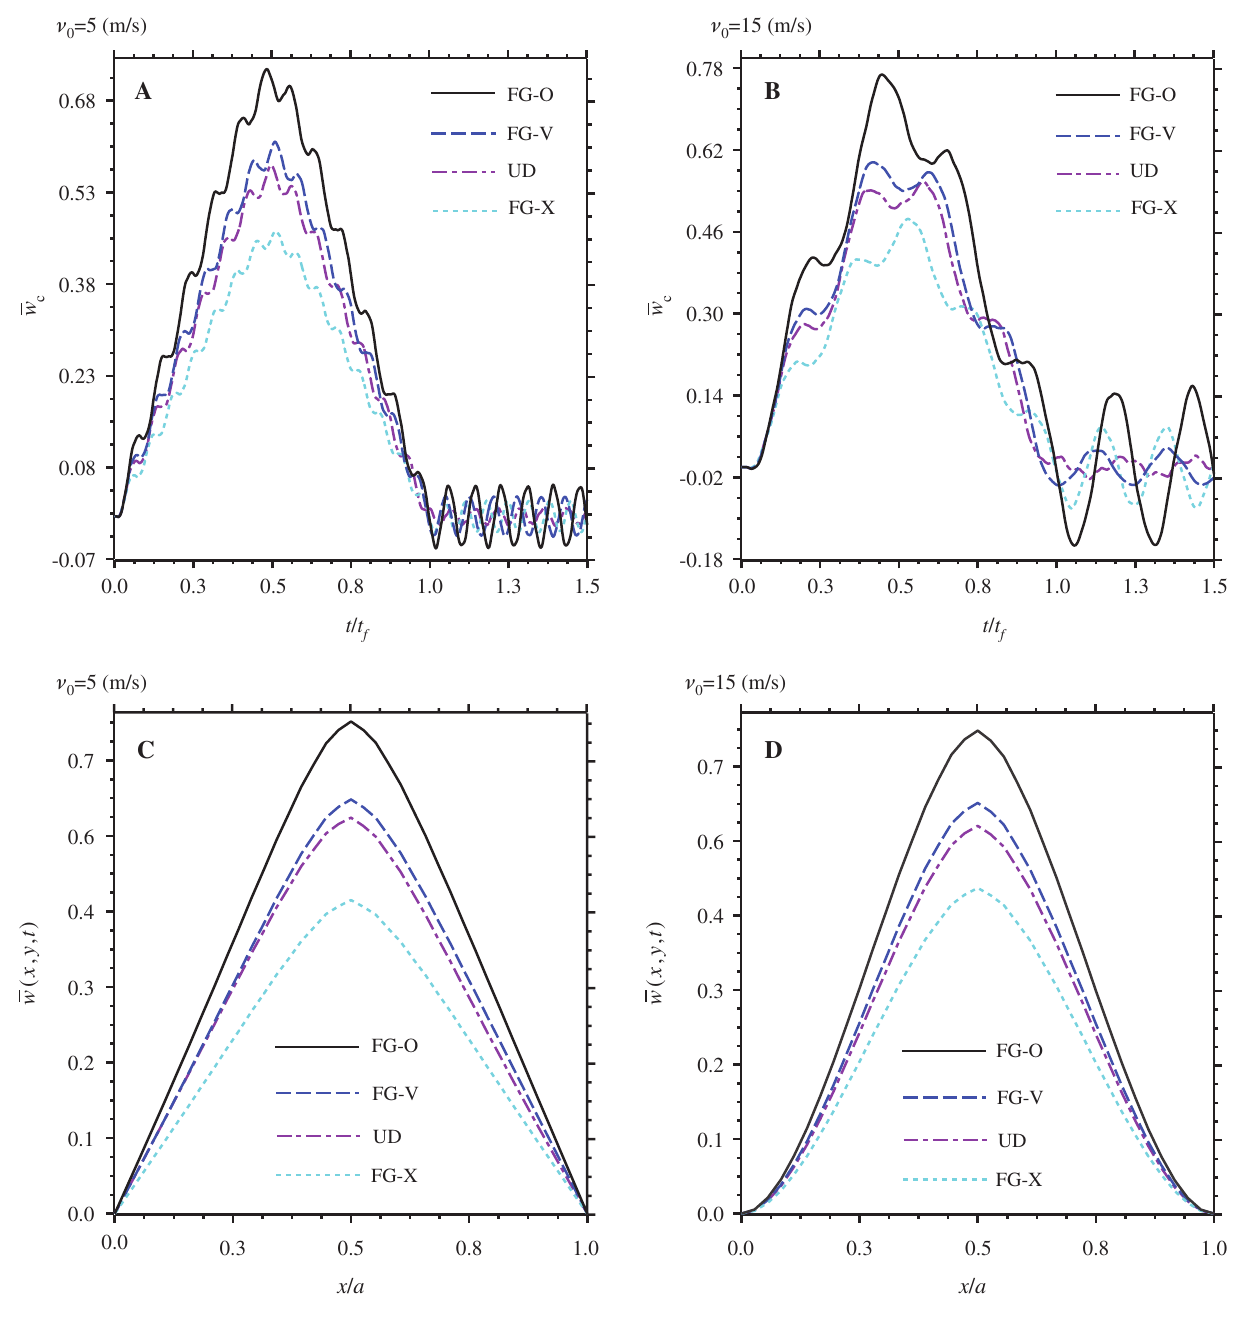
Figure 5 The influence of three different CNT distributions on the dynamic behavior of CNTRC plates with SCSC boundary conditions: (A, B) the time history of the nondimensional center deflection, (C, D) the profile of the material line y = b /2 at t = 0.5 t